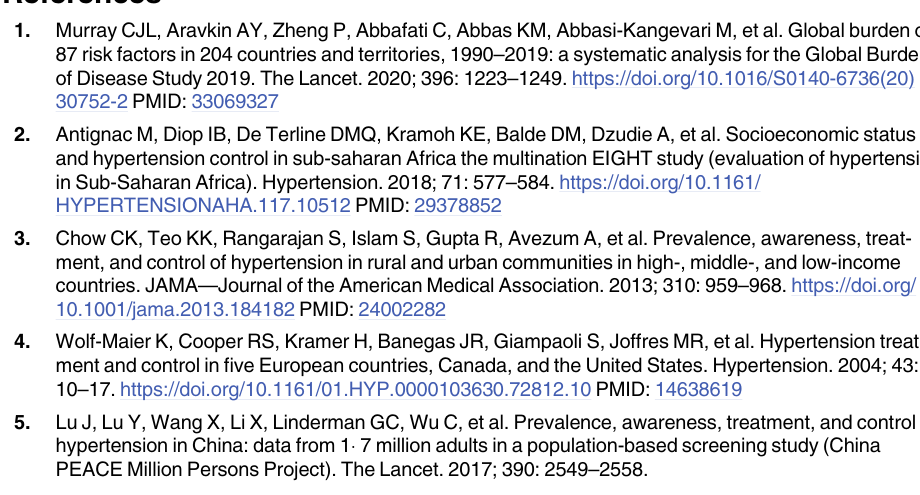
S3 Table. Prevalence of hypertension and unaware, untreated, and uncontrolled hyperten- sion, incomplete case sample. S4 Table. Transitions between hypertension states between Wave 1 and Wave 2, incom- plete case sample. S5 Table. Transitions from hypertension diagnoses and treatment to control, respondents with hypertension in both waves. S6 Table. Averaged marginal effects (ME) on probabilities of transitioning to diagnosed, treated, and controlled